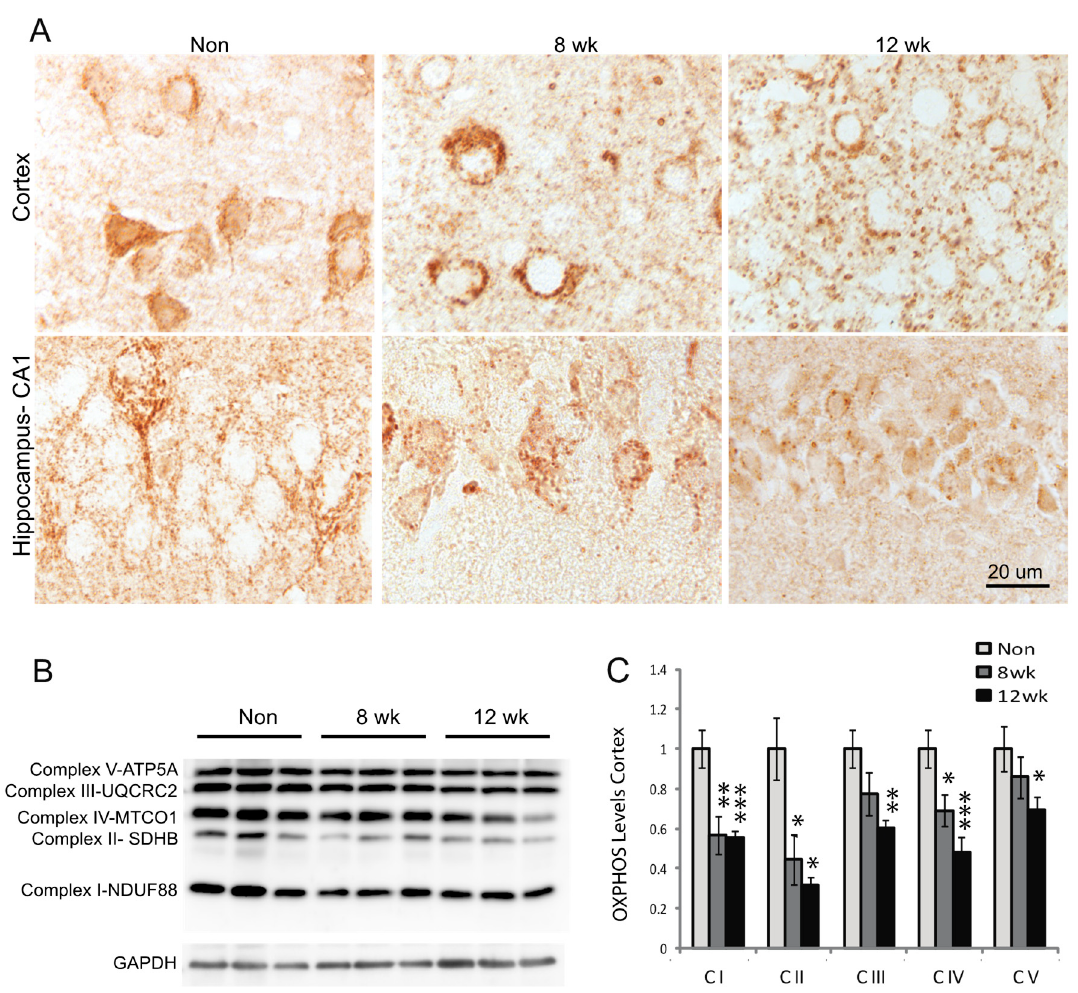
Figure 2. Loss of Mfn2 results in mitochondria abnormalities. Mitochondria immunostained using monoclonal OXPHOS antibody were consistently found throughout the soma and neuronal processes in hippocampal and cortical neurons in non-induced control mice ( A ). At 8 weeks post-induction, mitochondria were found clustered in the soma and not the processes, and some larger round structures, presumably swollen mitochondria, were found in the cortex ( A ). By 12 weeks post-induction, more, larger round structures approximately 0.5–2 microns in diameter were present throughout the cortex, and the hippocampal mitochondria staining was greatly reduced ( A ). By western blot analysis, mitochondria complexes I–V were all found decreased by 12 weeks post-induction ( B ). Quantification, relative to GAPDH as a loading control, determined that even at 8 weeks, complexes I, II, and IV were significantly reduced ( C ). * p < 0.05; ** p < 0.01; *** p < 0.001.